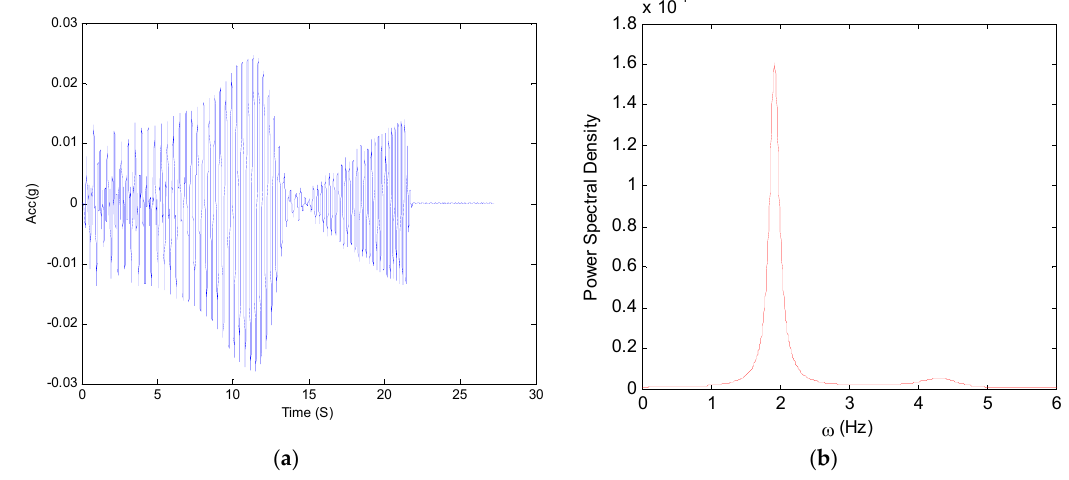
Figure 5. Excitation dynamic signal: ( a ) time domain signal; and ( b ) frequency domain contents.